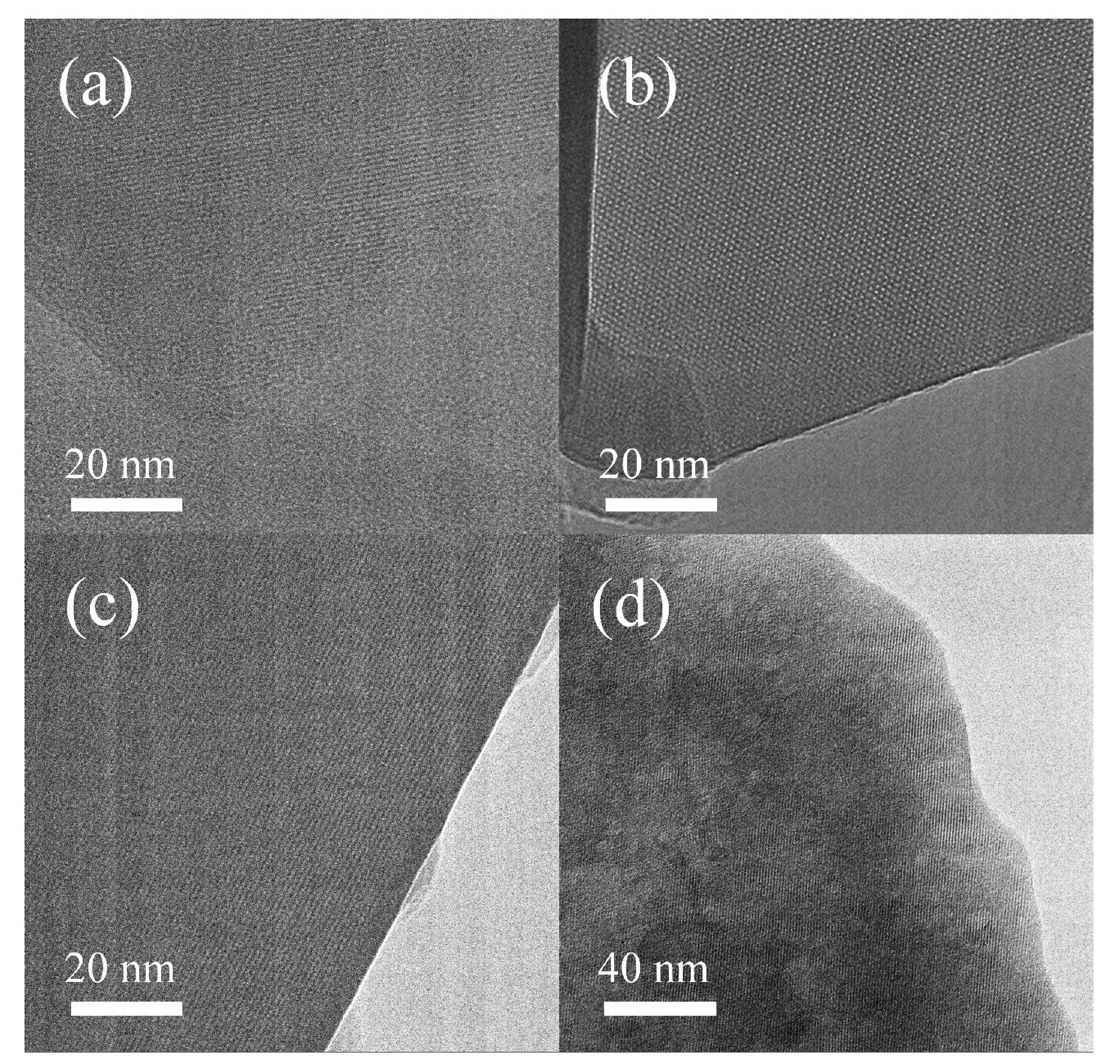
Figure 3. High-resolution scanning transmission electron microscopy (HR-STEM) image: ( a ) HZSM- 5(38), ( b ) 5%CaO/HZSM-5(38), ( c ) 10%CaO/HZSM-5(38) and ( d ) 20%CaO/HZSM-5(38) catalysts.